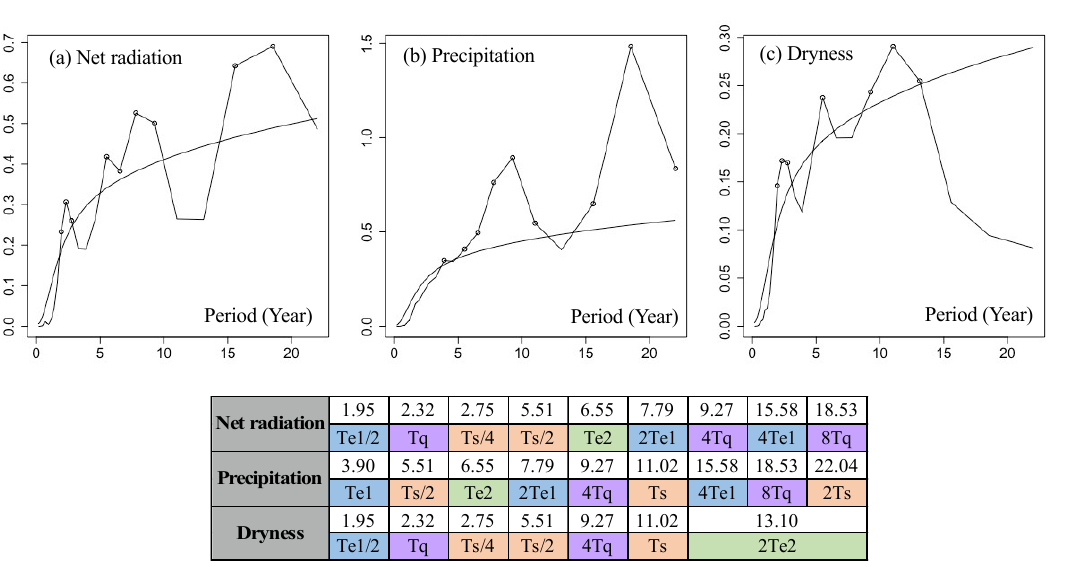
Figure 6. Time series of annual means of ( a ) the normalized driving force generated by slow feature signals when m = 13 and ( b ) the power spectrum of the wavelet transform coefficient for the reconstruction of the driving force for ( I ) net radiation, ( II ) precipitation, and ( III ) dryness ratio. Significant regions are surrounded by black isolines.